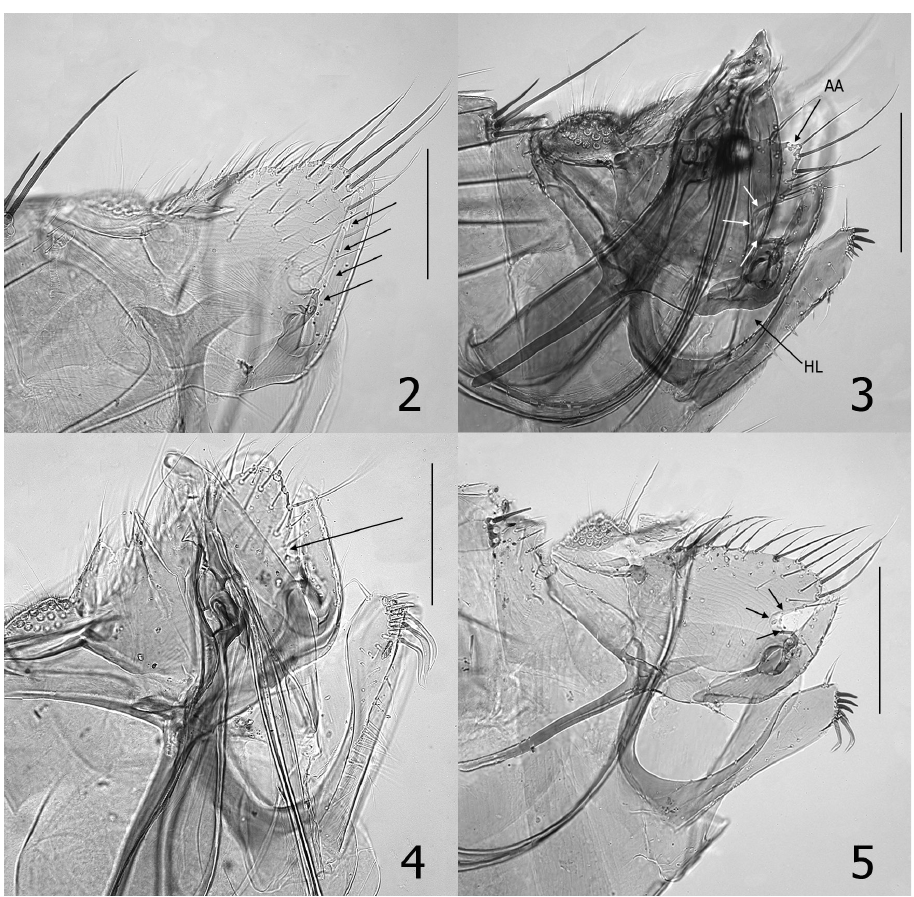
Figures 2–5. 2 Phalacropsylla allos male basimere and telomere. Arrows define ventral margin of basimere without sinus 3 Phalacropsylla nivalis male basimere, telomere, distal arm of S-IX, and aedeagus. White arrows define margin of sinus in ventral margin of basimere. AA = angular apex of basimere; HL = hyaline lobe of distal arm of S-IX 4 Phalacropsylla oregonensis , male holotype basimere, telomere, and distal arm of S-IX. Arrow indicates small sinus in ventral margin of basimere 5 Phalacropsylla paradisea , male basimere, telomere, and distal arm of S-IX. Arrows define margin of deep sinus on ventral margin of basimere. Scale = 0.2